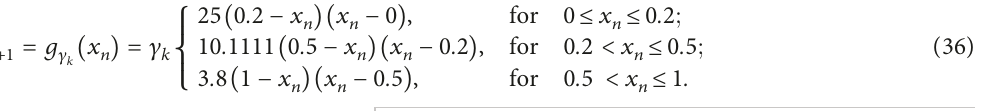
Figure 5: Cobweb Diagrams obtained from trimodal family equation (36) for initial condition x ( x ) (c) g c n 3 � 4